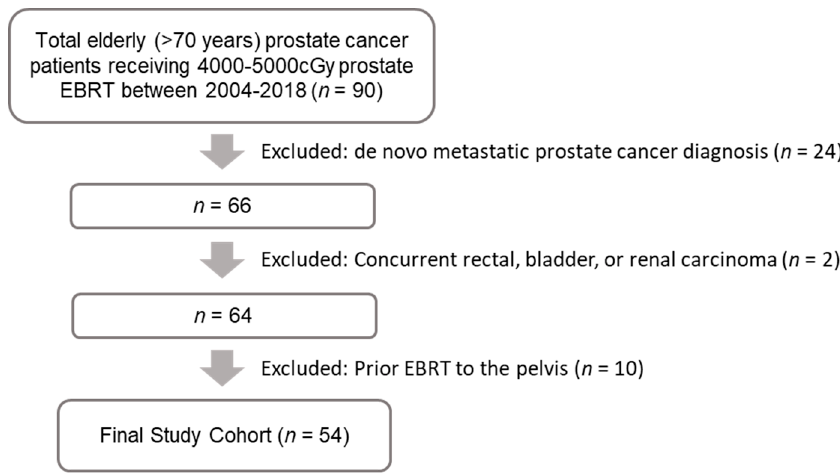
Figure 1. Flow diagram with number of patients excluded from analysis and reasons for their exclusion.